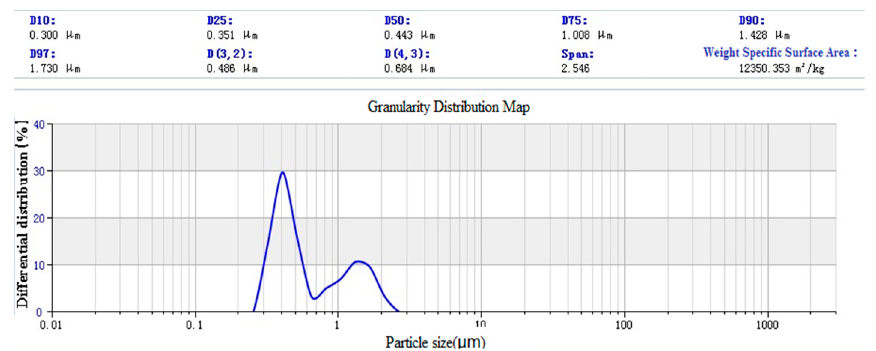
Figure 15. Paraffin @ Nano-SiO 2 Laser Particle Size Analysis Diagram.